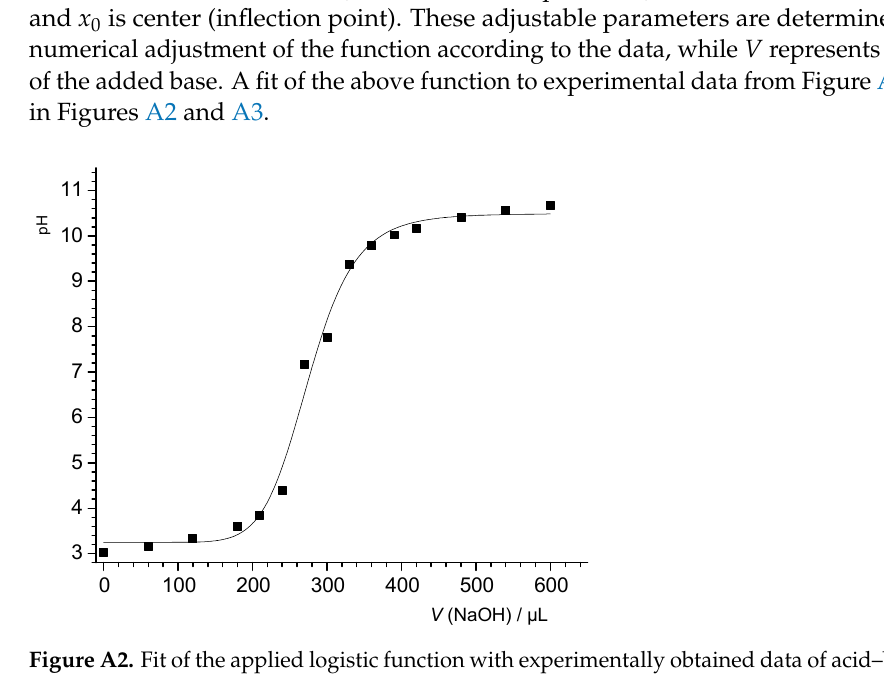
Figure A2. Fit of the applied logistic function with experimentally obtained data of acid–base titration of aqueous NaCl solution without CNT particles.